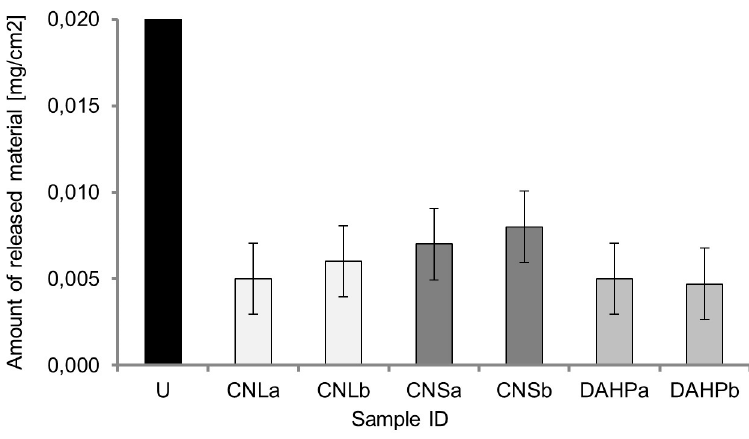
Figure 7. Scotch tape test on untreated and treated specimens.